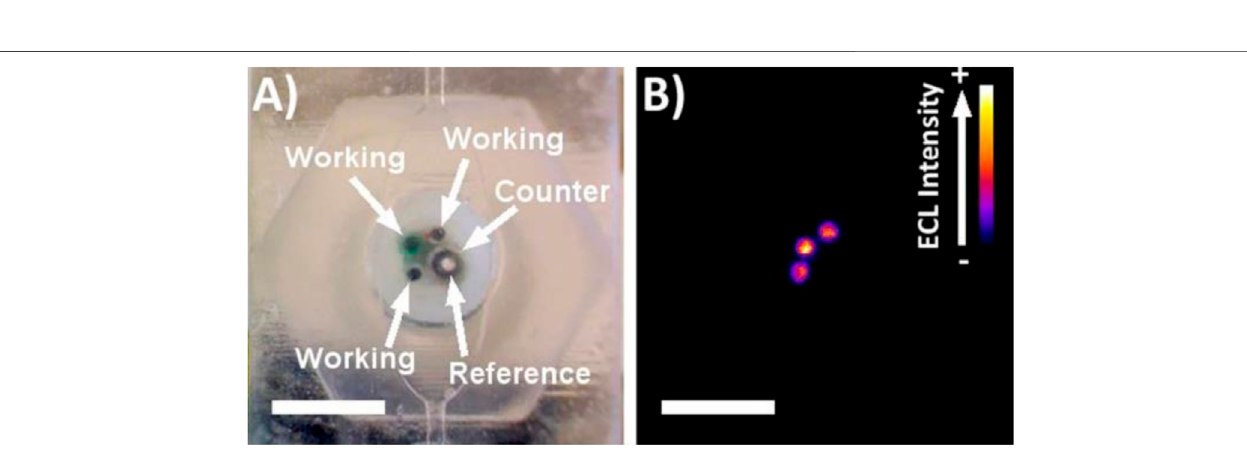
Frontiers in Nanotechnology |